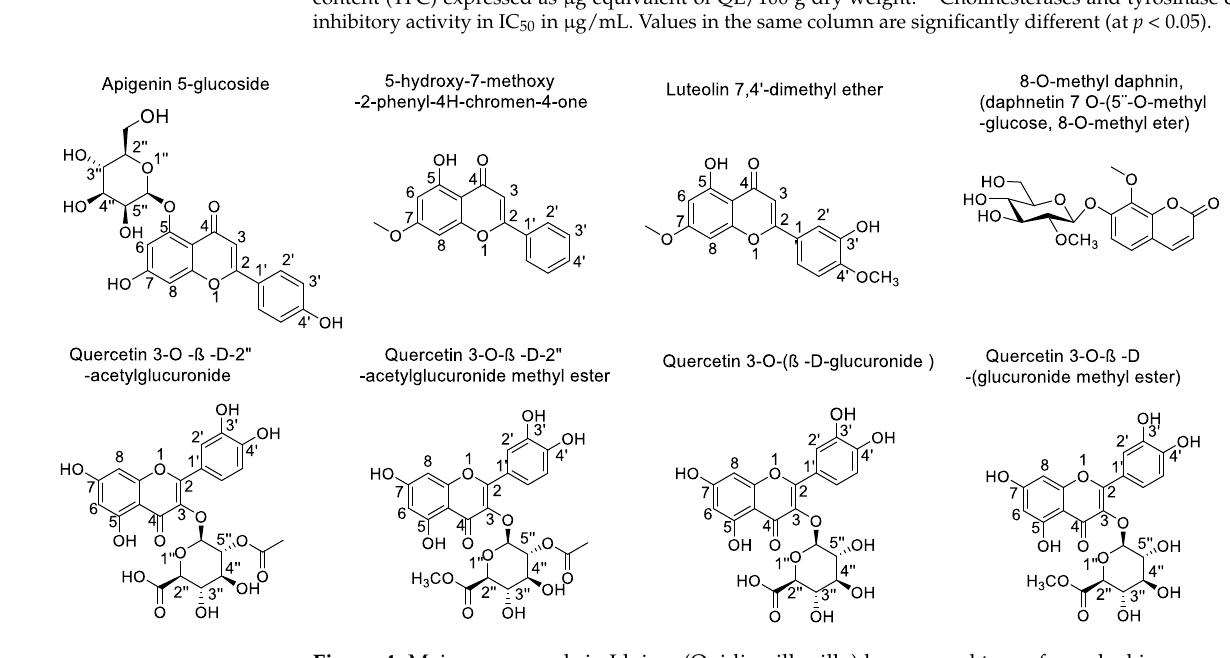
Figure 4. Main compounds in Lloime (Ovidia pillopillo) leaves used to perform docking experiments into the corresponding catalytic sites of acetylcholinesterase, butyrylcholinesterase, and tyrosinase. Table 3. Binding energies obtained from docking experiments of most abundant compounds in Lloime leaves extract, as well as binding energies of the known inhibitors, galantamine and kojic acid